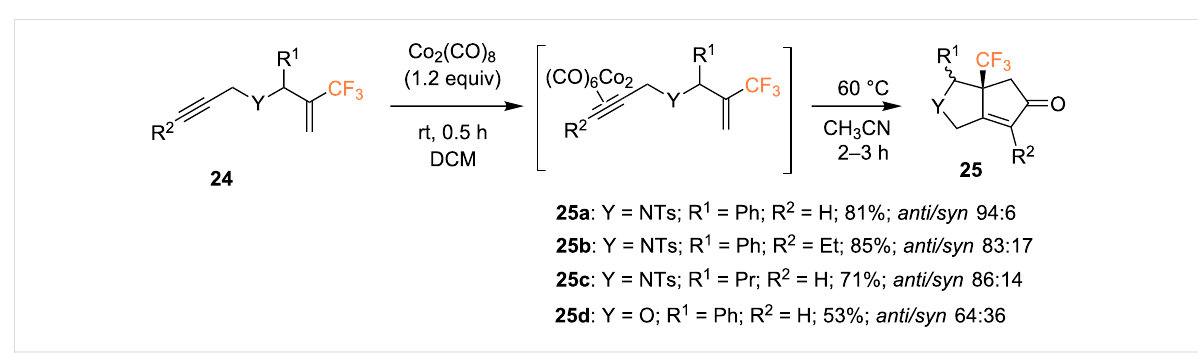
Scheme 11: Intramolecular PKR of 1,6-enynes reported by the group of Ichikawa